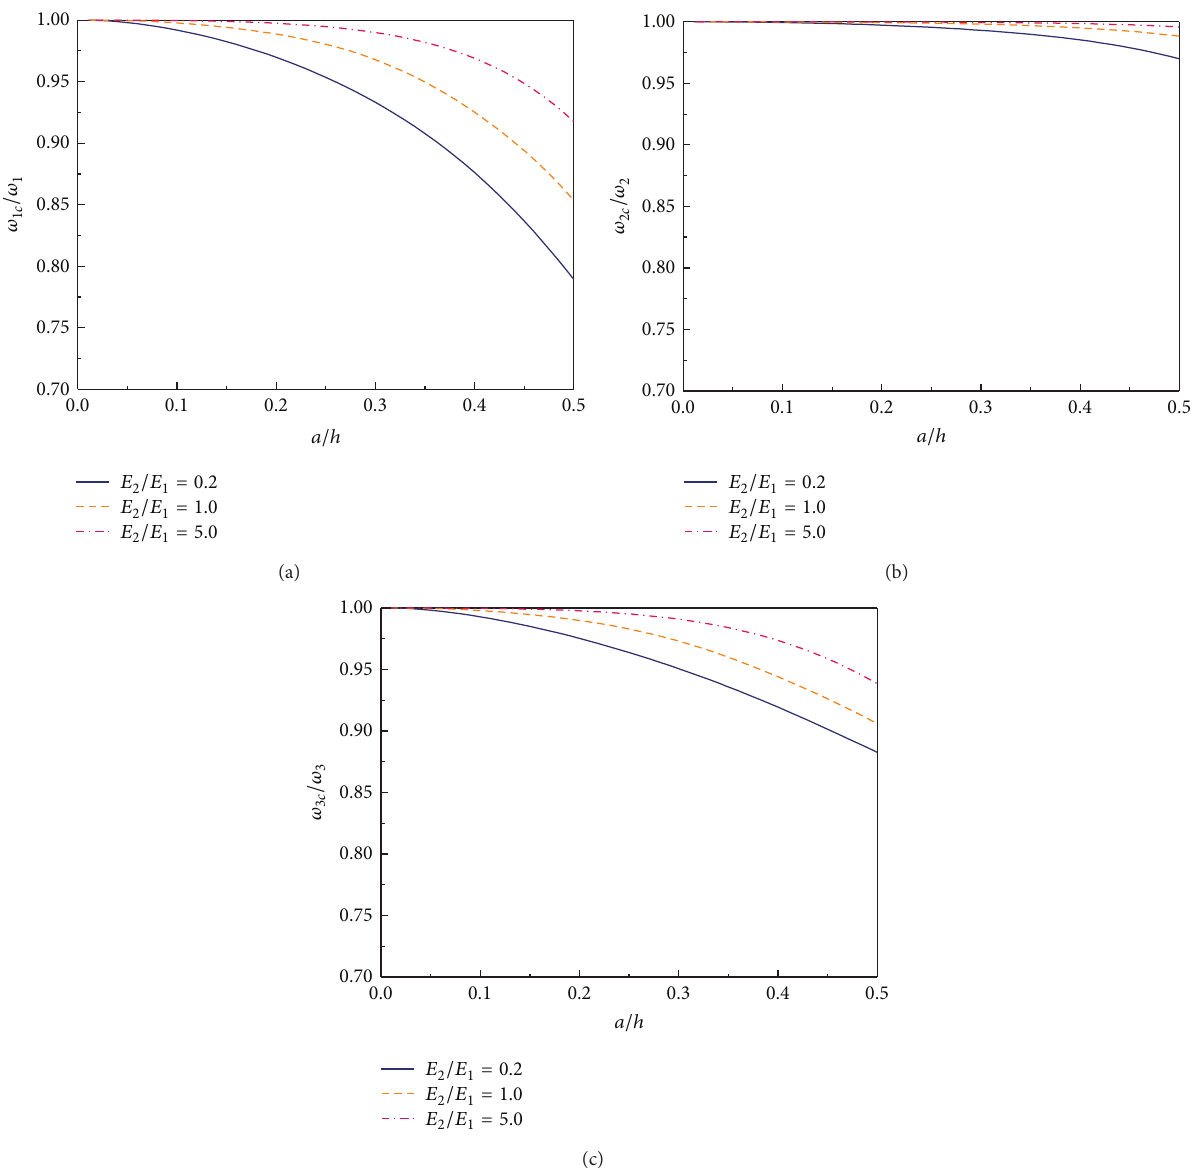
Figure 7: The first three frequency ratios of hinged-hinged FGM beams with different Young’s modulus ratios and containing a single open edge crack of varying depths: (a) the fundamental frequency ratio, (b) the second frequency ratio, and (c) the third frequency ratio.